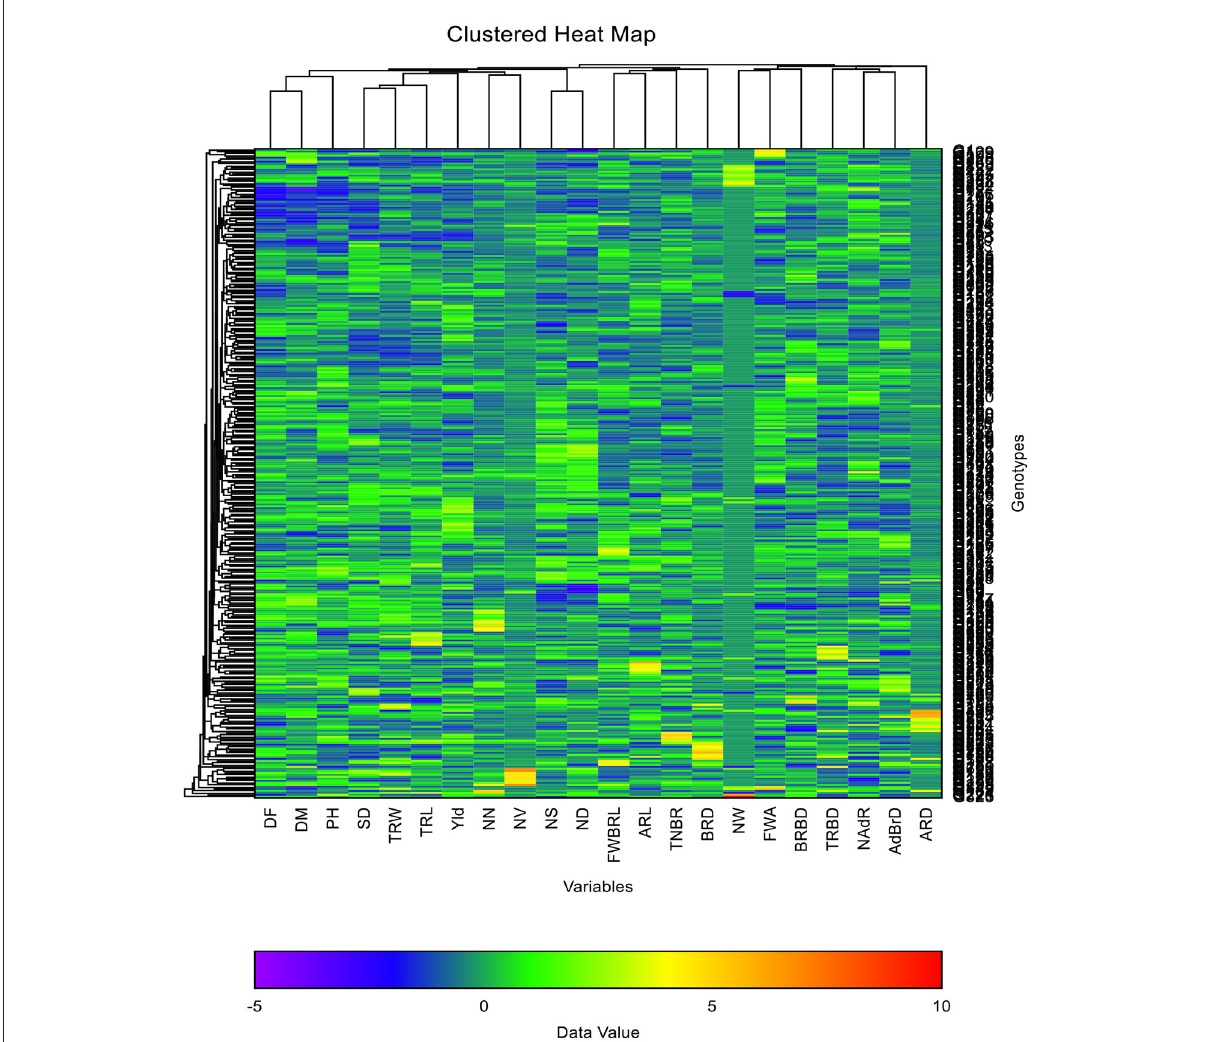
FIGURE4 Clustered heat map showing the correlation between genotypes and root morphometric and architecture traits. DF, days to flowering; DM, days to maturity; PH, plant height; Yld, grain yield; SD, stem diameter; NW, number of whorls; FWA, 1st whorl angle; FWBRL, basal root length 1st whorl; TNBR, total number of basal roots; BRBD, basal root branching density; BRD, basal root diameter; TRW, taproot width; TRBD, taproot branching density; TRL, taproot length; NAdR, number of adventitious roots; ARD, adventitious root diameter; ARL, adventitious root length; NN, number of nodules; NS, nodule size; ND, nodule distribution; NV, nodule volume; AdBrD, adventitious root branching